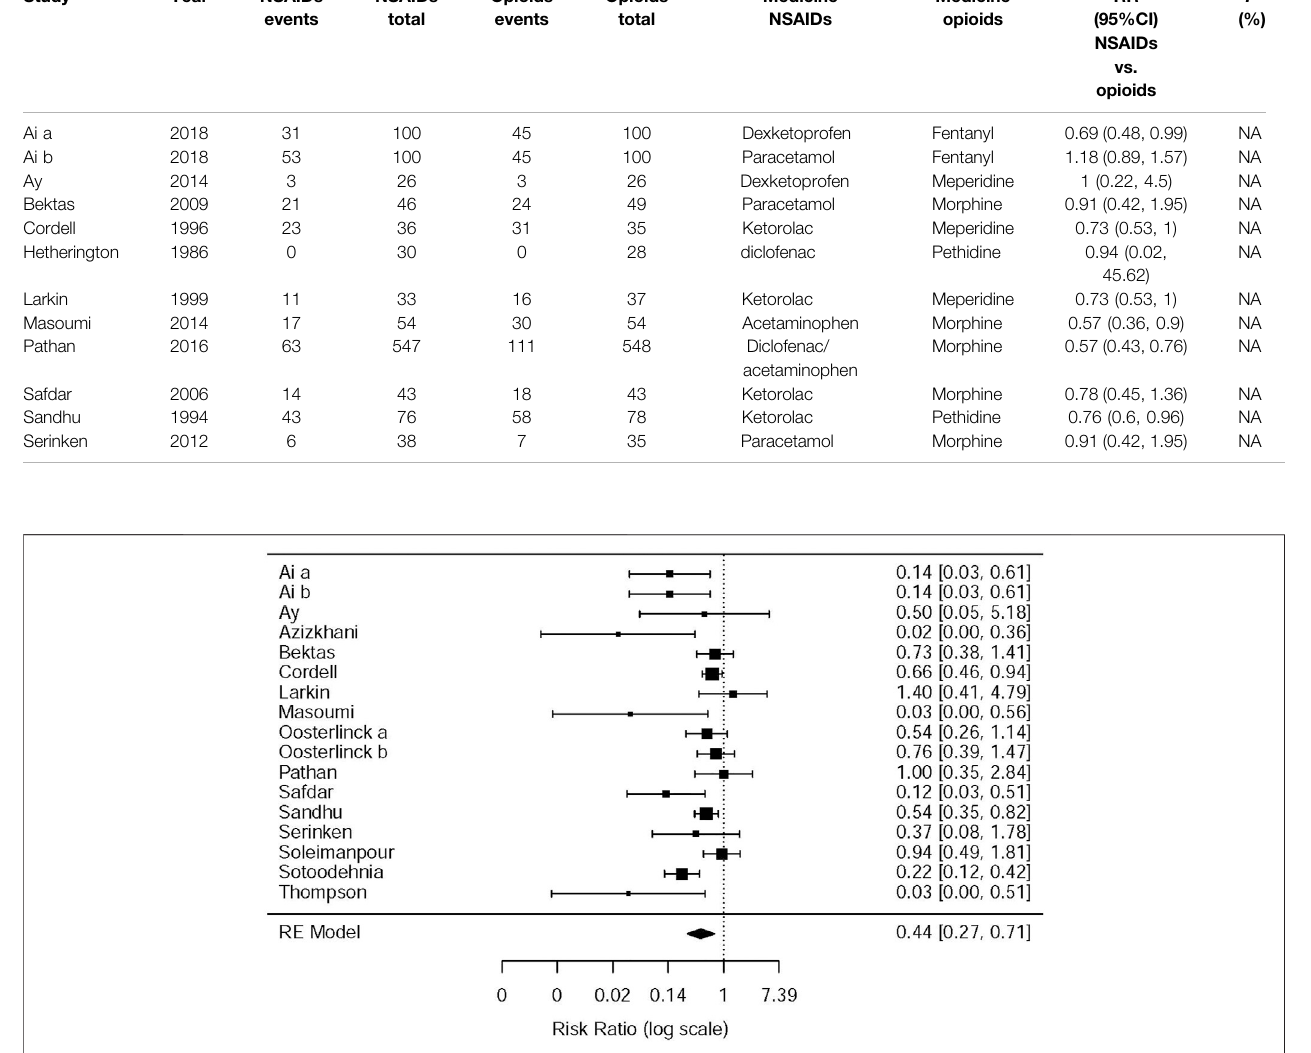
FIGURE 7 | The results of meta-analysis for side-effects caused by the medication.